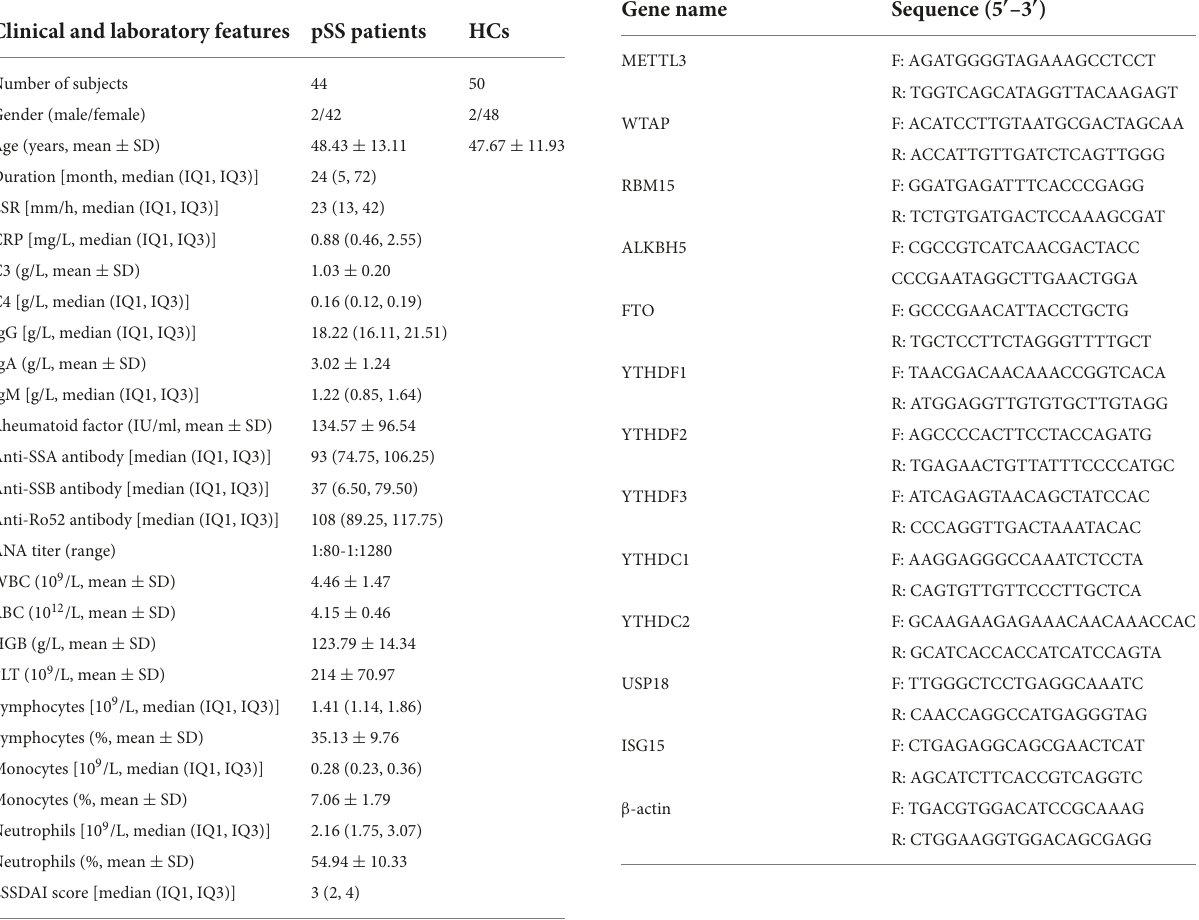
( Figure 3 ). Patients with pSS had lower mRNA levels of YTHDF2 ( P = 0.011), YTHDF3 ( P < 0.001), and YTHDC2 ( P = 0.006) relative to patients with non-SS sicca. No significant difference was found in the expression of YTHDF1 ( P = 0.438) and YTHDC1 ( P =